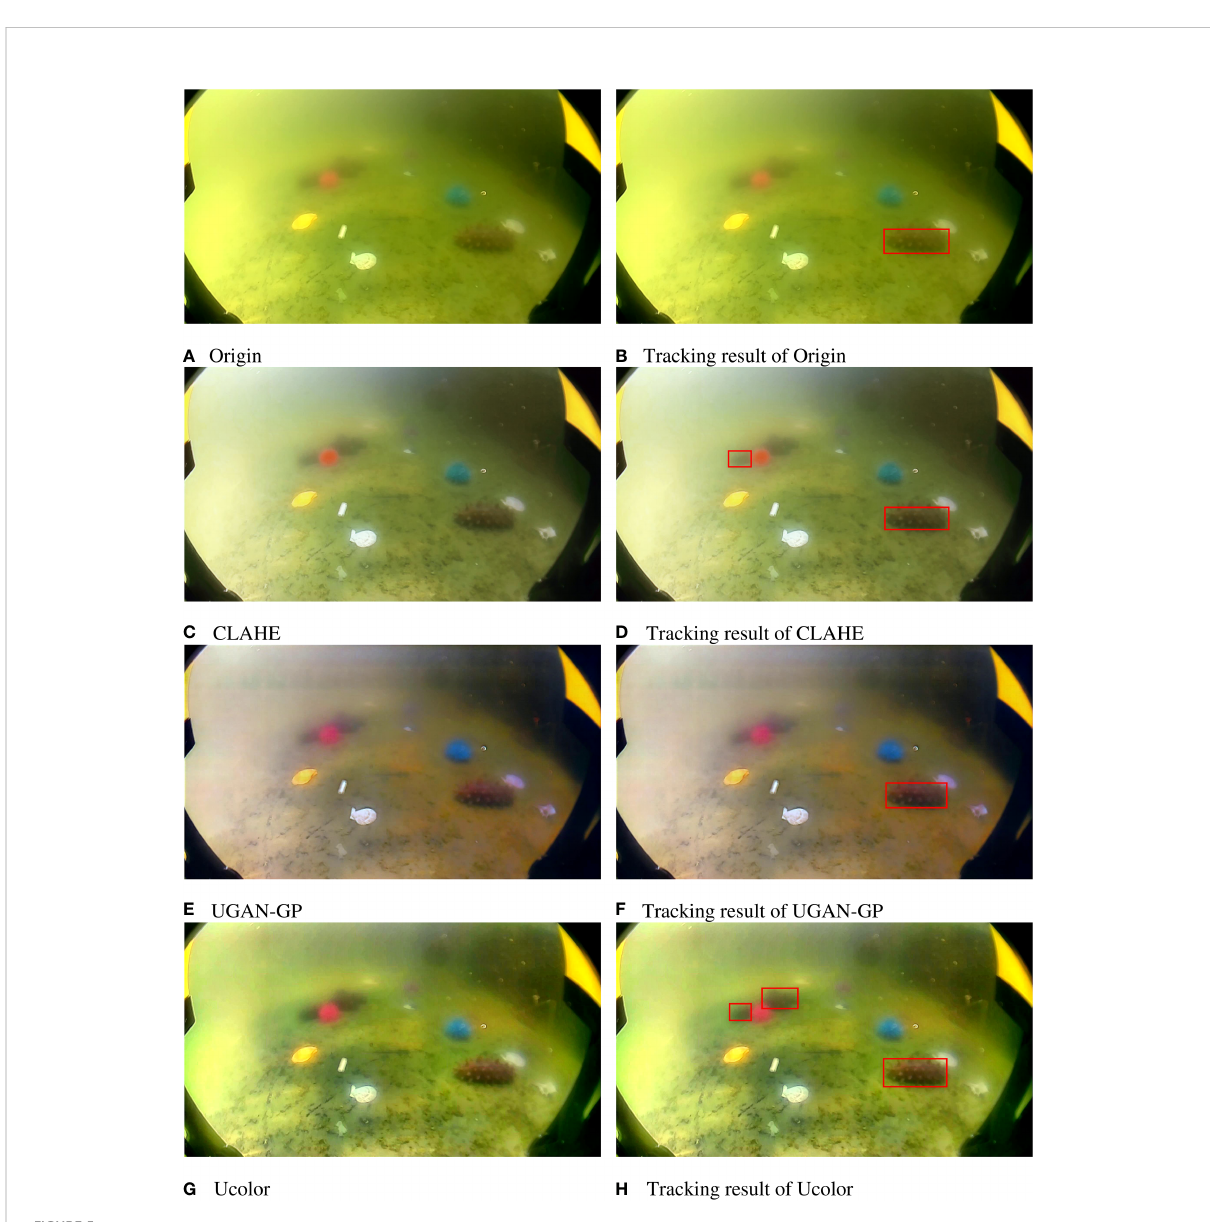
FIGURE 5 Visualization of the results generated by the different enhancement modules.